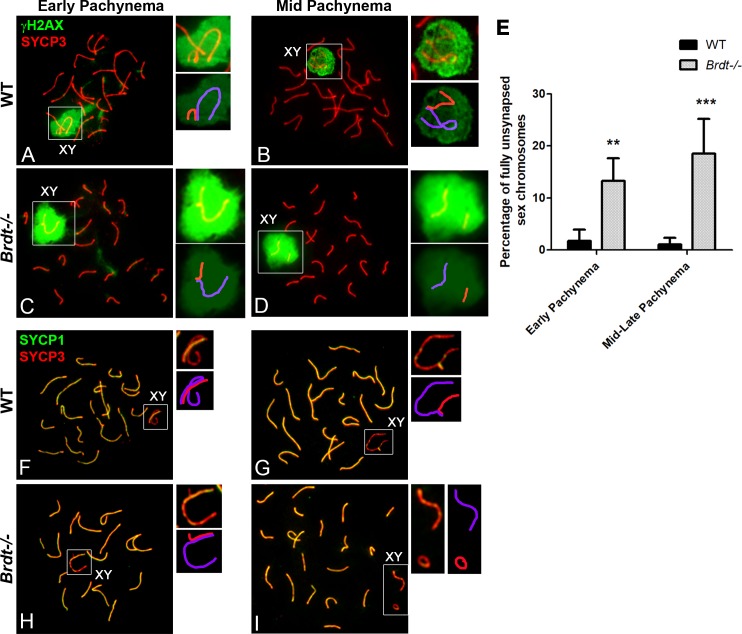
Depletion of BRDT does not affect the global DSB repair and synapsis of autosomes, but results in asynapsis of the sex chromosomes during pachynema.(A-D, F-I) Chromosome spreads of wild type (WT) and Brdt-/- early and mid pachytene spermatocytes. Upper insets show an enlargement of the sex chromosomes. A schematic representation of each inset is shown below the original, with the X chromosome represented in purple and the Y chromosome in red. (A-D) Immunolocalization of γH2AX (green) and SYCP3 (red). (A, C) In both WT and Brdt-/- early pachytene spermatocytes, γH2AX is present in the sex chromosomes and as foci in the chromatin adjacent to the SC. (B, D) At mid pachynema, γH2AX is observed only in the X and Y chromosomes, including those in complete asynapsis (D, inset). (E) Quantification of sex chromosomes with synapsis defects at the PAR in WT (black bar) and Brdt-/- (grey bar) spermatocytes. Samples were obtained from three WT and Brdt-/- 3 month-old mice. n = 62 and 99 early pachytene, and 125 and 132 mid/ late pachytene WT and Brdt-/- spermatocytes respectively. **p<0.01, ***p<0.001. (F-I) Immunolocalization of SYCP1 (green) and SYCP3 (red). In WT early (F) and mid pachynema (G), all chromosomes are fully synapsed, including the sex chromosomes. (H-I) Brdt-/- spermatocytes exhibit fully synapsed autosomal bivalents, but numerous sex chromosomes are completely unsynapsed (I, inset).